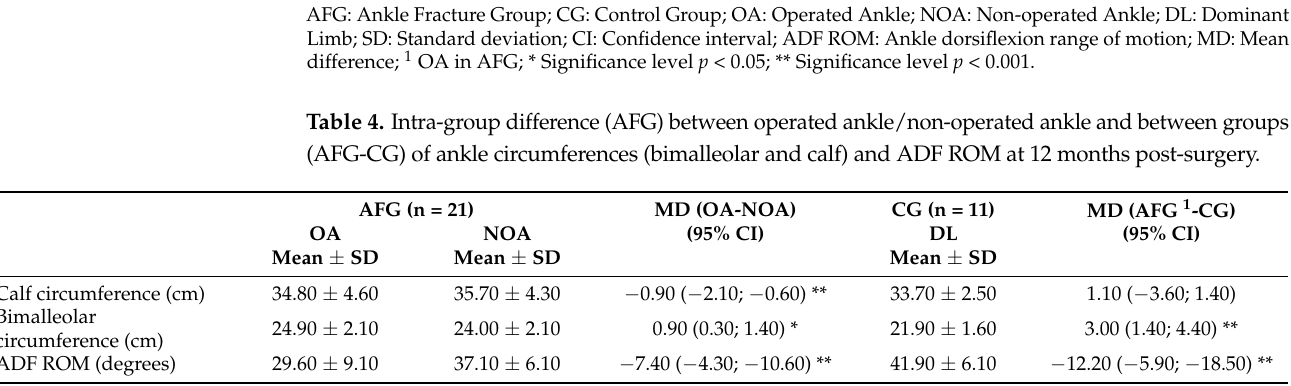
AFG: Ankle Fracture Group; CG: Control Group; OA: Operated Ankle; NOA: Non-operated Ankle; DL: Dominant Limb; SD: Standard deviation; CI: Confidence interval; ADF ROM: Ankle dorsiflexion range of motion; MD: Mean